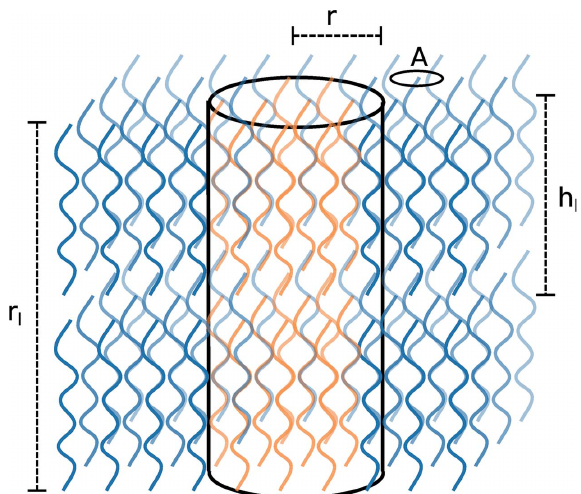
Figure 7 Schematic representation of a nucleus in a layered system. The nucleus is assumed to be cylindrical in shape of height r l and radius r . The height of an individual layer is h l and the area an individual molecule occupies in the layer is A .